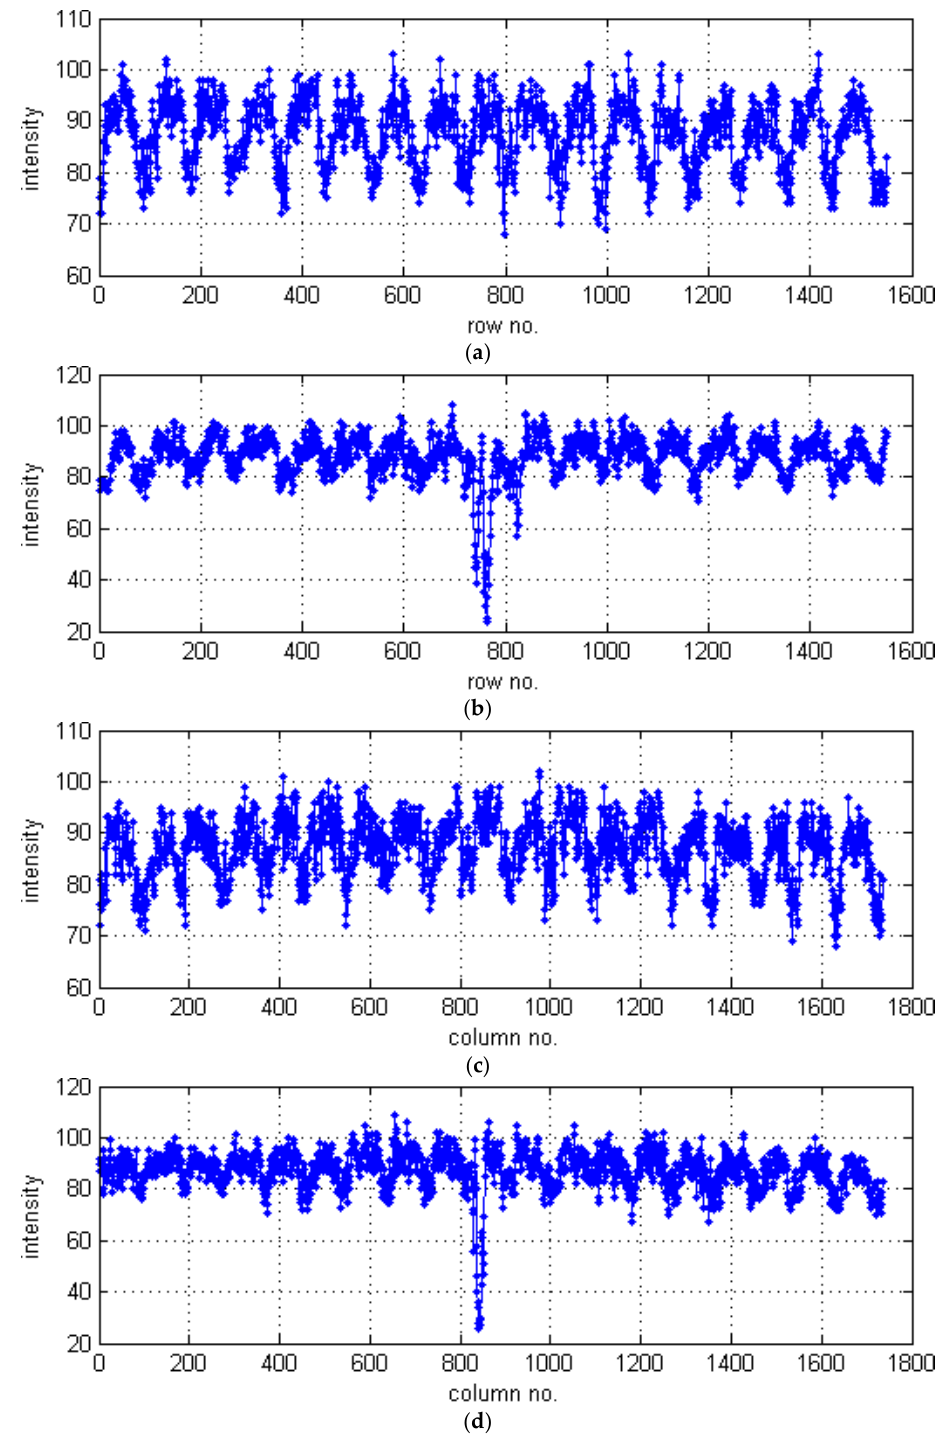
Figure 17. Data vectors extracted for selected CT image sections: ( a ) column no. 368; ( b ) column no. 814; ( c ) row no. 357; ( d ) row no. 726.